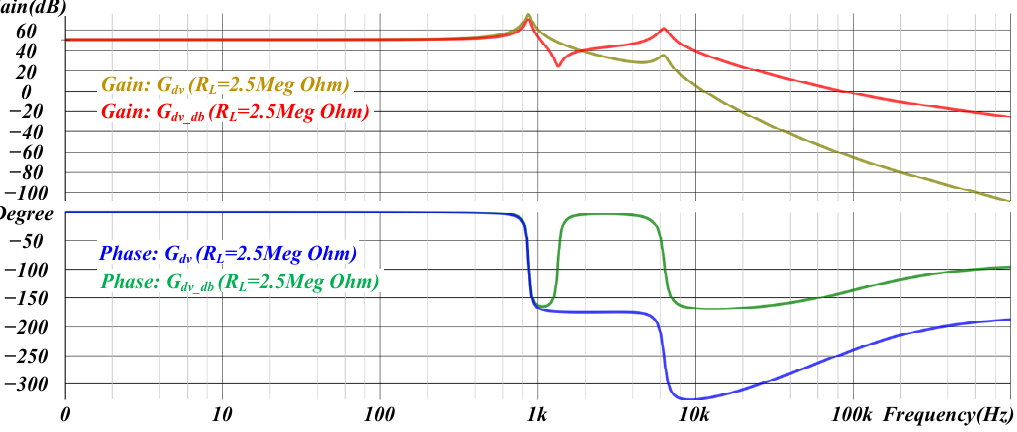
Figure 23. Bode plots of G dv and G dv_bd .